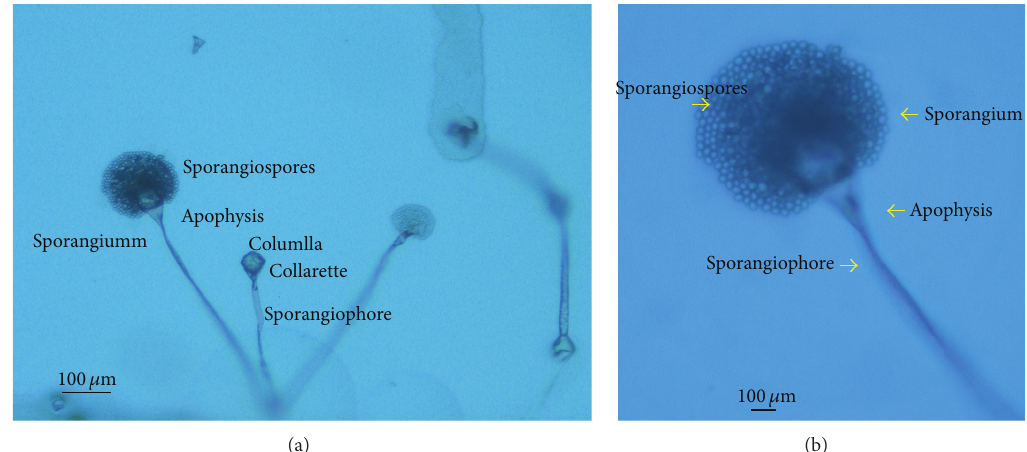
Figure 2: Microscopic features of the Rhizopus species isolated from bronchoalveolar lavage culture of the patient. (a) Sporangiophores are long and nondichotomous, usually terminating in large globose sporangia (100 × ). (b) Sporangiophore with sporangium contains numerous sporangiospores (400 ×